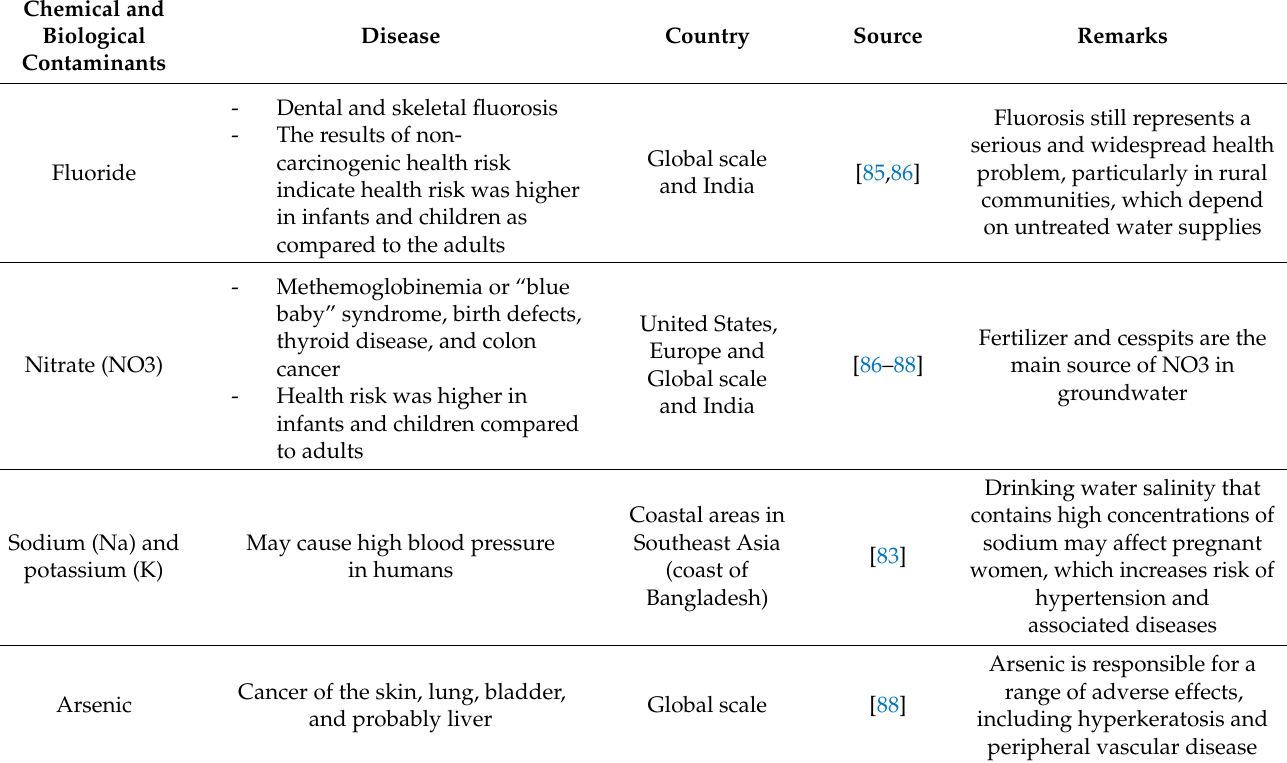
Table 6. Study on diseases associated with chemical and biological contamination of drinking water around the